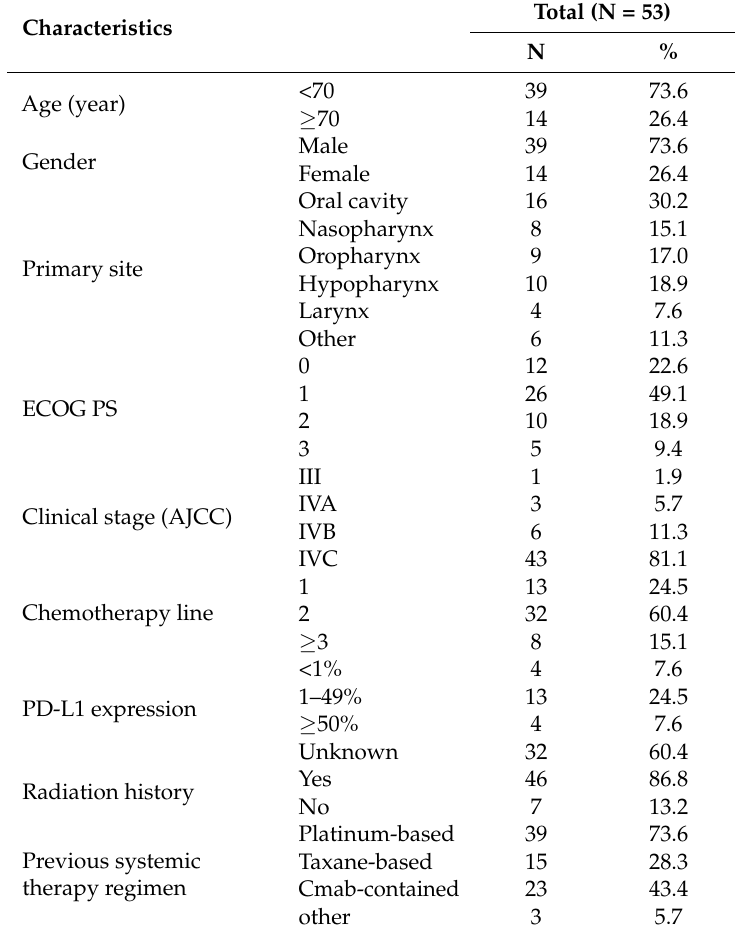
Table 1. Patient